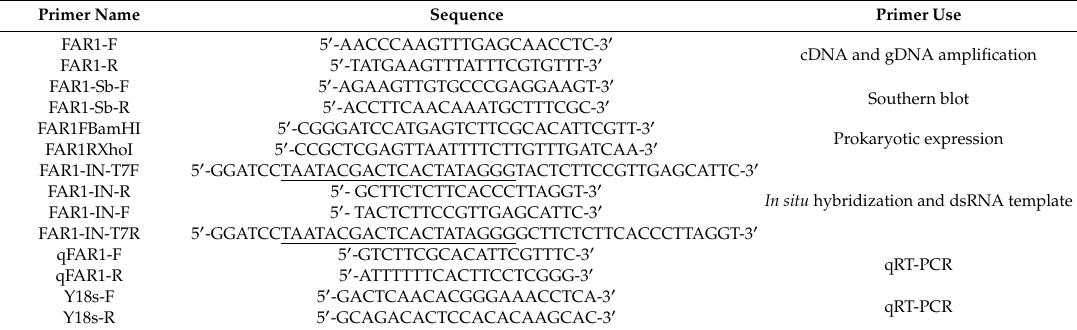
Table 1. Primers used in this study.